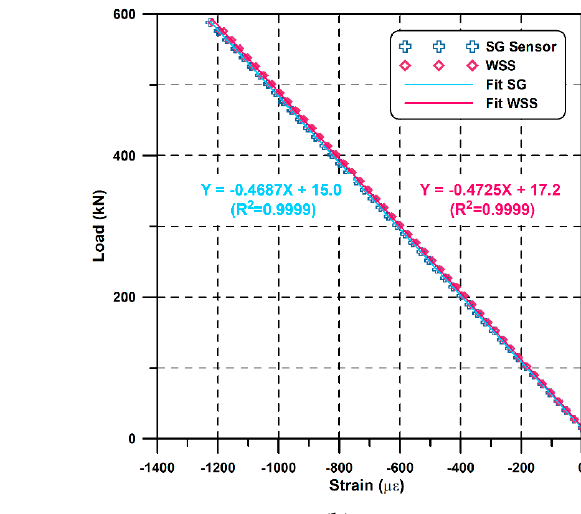
Figure 10. Uniaxial load test results before the FRP protection: ( a ) OR-SG; ( b ) WSS-SG. The effect of FRP-forming on the sensor response is presented in Figure 11, which shows the results before and after the protection of the OR sensor and WSS. The slope of the WSS and OR sensor differ only by 0.0007 kN/ με and 0.00035 kN/ με before and after the protection, with a high fidelity of R 2 values of 0.9998 and 0.9999, respectively, which indicates that sensor protection does not affect the sensor response characteristics.